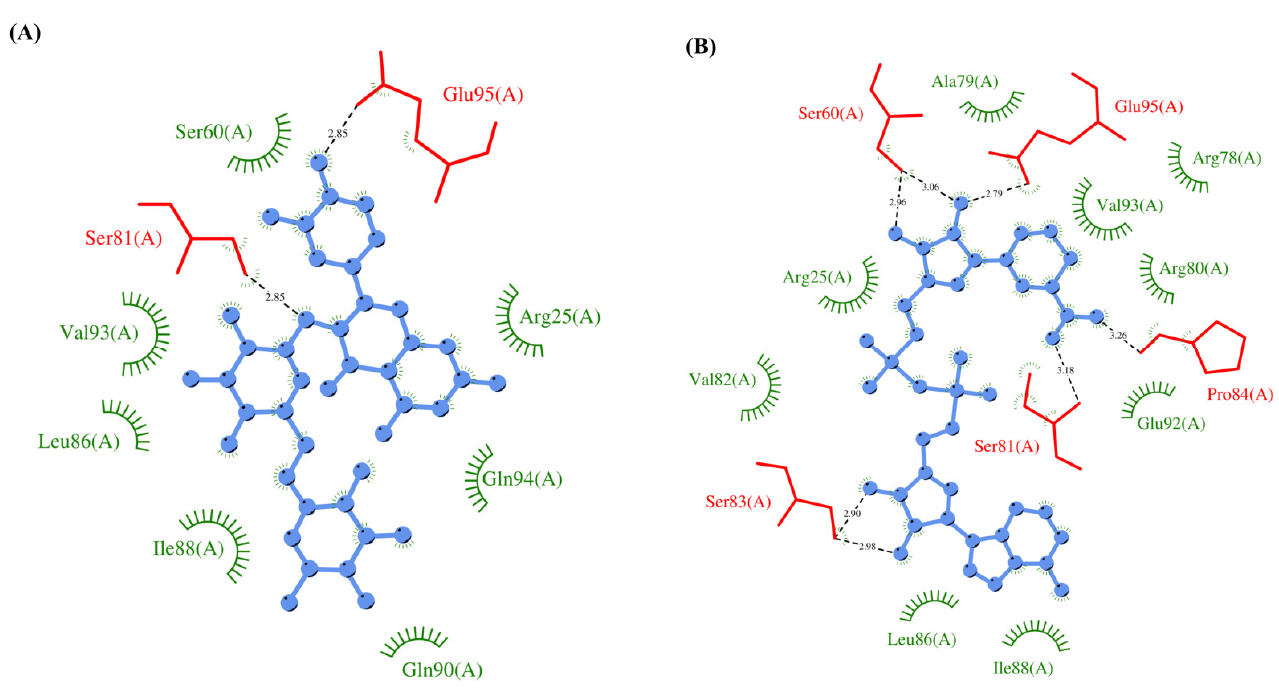
Figure 13. ORF7a. ( A ) Molecular interactions of protein with Rutin ( B ) Molecular interactions of protein with NADH.